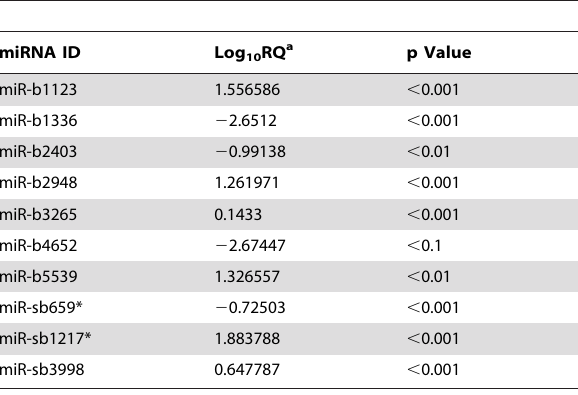
Table 3. Putative novel miRNAs differentially expressed in sALS and control spinal cords.